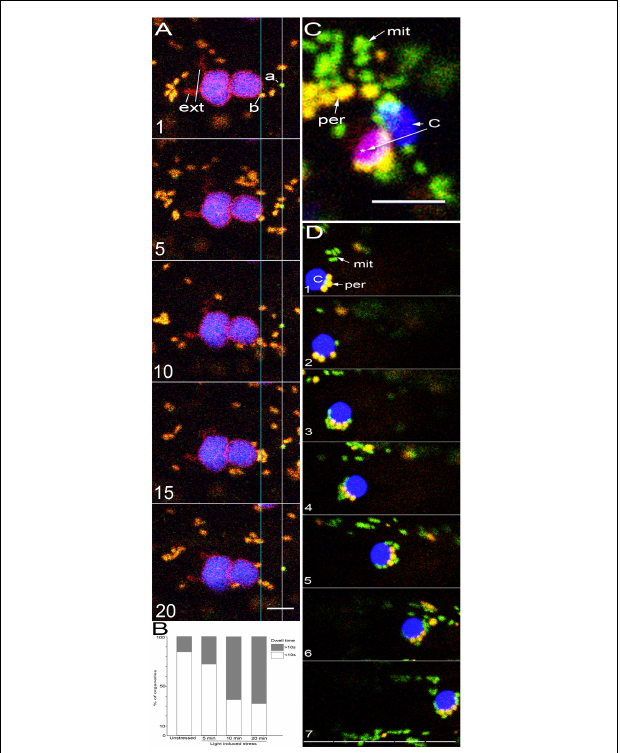
FIGURE 1 | Several different possibilities for organelle interactions are observed in living cells. (A) Five snapshots used to illustrate the ideas of coincidental interactions, sustained proximity based on long dwell time and no possible direct interactions when chloroplasts, peroxisomes and mitochondria clearly remain at a distance from each other. The consecutive images are from 100 frames representing about 200 s of imaging ( Supplementary Movie 1 ). A peroxisome labeled “a” maintains its position at a distance from the two chloroplasts observed for 100 frames. A mitochondrion labeled “b” maintains a position at or within 500 nm of the plastid OEM for 100 frames or a total dwell time of 200 s. During this time up to 6 other mitochondria cluster near it but the cluster is maintained only for a maximum of 45 frames or dwell time of 90 s. Other than one mitochondrion that is present close to the plastid OEM during the 200 s, the rest do not exhibit sustained proximity with the plastid or with a peroxisome. The single instance of a peroxisome and mitochondria appearing in frame 15 and the several frames with mitochondrial clusters are considered coincidental occurrences. Notably, two extensions (ext) are present in the chloroplast (C) but neither mitochondria or peroxisomes exhibit sustained proximity with them. (B) In unstressed plants, on the basis of 100 peroxisome and mitochondrial clusters with chloroplasts a dwell-time of less than 10 s (ca. 5 frames of our confocal scans) was arrived at for 83 clusters while the rest exhibited dwell time longer than 10 s. High light intensity induced stress by exposing plants for 5 min to light of 450 ± 25 µ mol m − 2 s − 2 resulted in the three organelle clusters with a dwell-time greater than 10 s to 29% Longer exposures of 10 and 20 min resulted the three-organelle cluster with dwell-time longer than 10 s to increase to 64 and 67%, respectively. (C) Organelles clustered after a 20-min exposure to high light intensity also contain chloroplasts that based on the loss of chlorophyll autofluorescence appear bleached (pink *) compared to an unbleached chloroplast (blue -c). Plastids with degraded chlorophyll often maintained peroxisome clusters for long dwell time. (D) Seven consecutive images illustrating high light induced stress for 10 min that leads to increased proximity between the chloroplasts (blue -C), peroxisomes (per – yellow) and mitochondria (mit – green). A split scale bar with each unit representing 10 µ m shows that the clustered organelles remained together as they moved for at least 50 µ m. Scale bars – A = 5; C, D = 10 µ